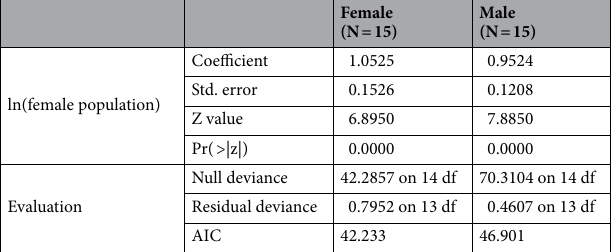
Table 7. Poisson regression models of county-level relationships between case count and population, built for reference counties . df degrees of freedom.